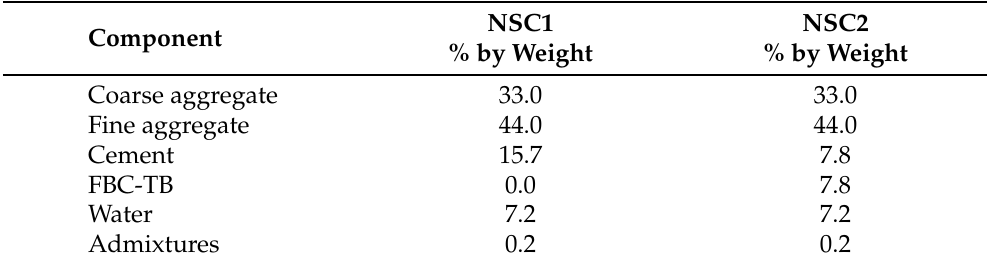
Table 1. Composition of both types of